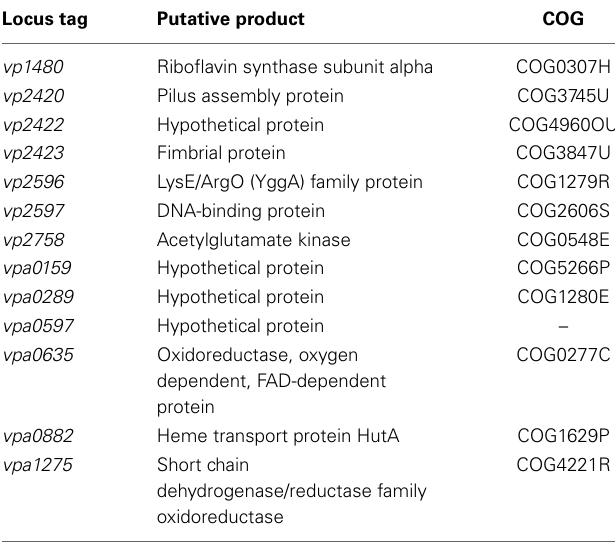
Table 1 | Genes showing ≥ 5-fold change ( P < 0 . 05) in expression in DMEM compared to LB-S conditions and in trans exsA compared to in trans exsD expression *